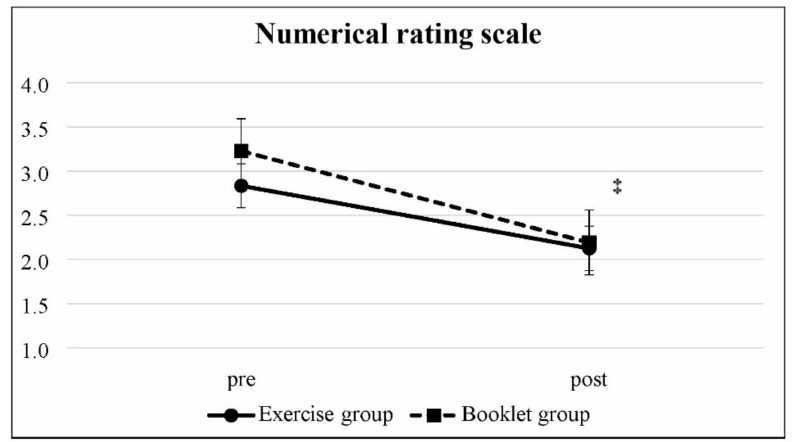
Figure 2. Numerical rating scale: Mean scores with 95% confidence intervals at the pretest and posttest. ‡ Significant difference between pretest and posttest in the booklet group.